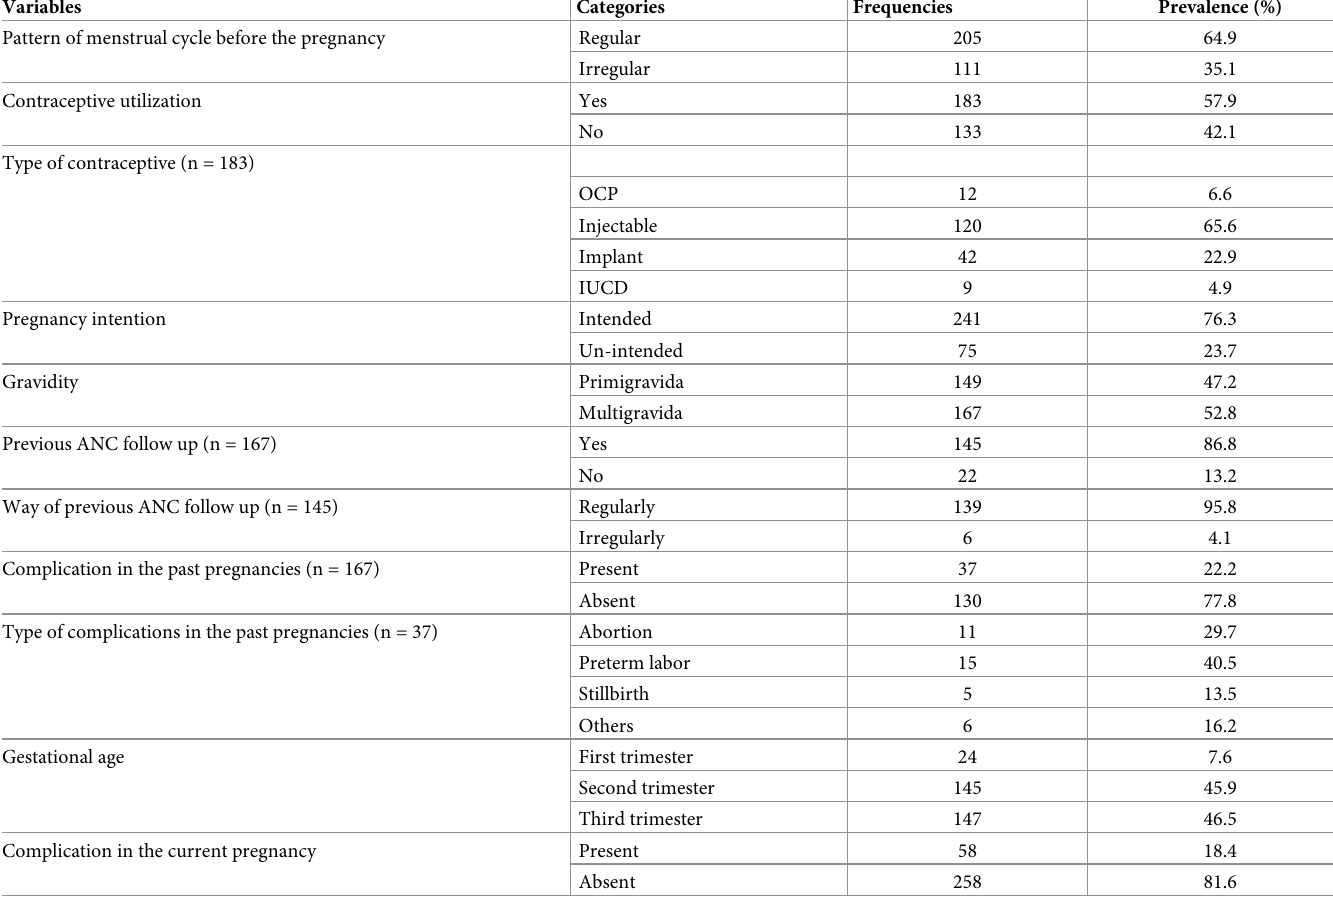
Table 2. Obstetric factors among pregnant women attending public health facilities in Arba Minch SNNPR Ethiopia 2018.